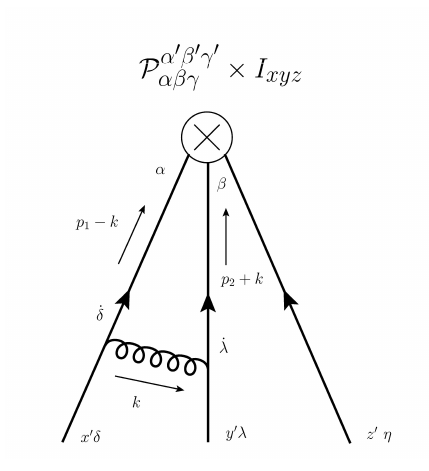
Figure 2: Example of loop diagram giving rise to eq.